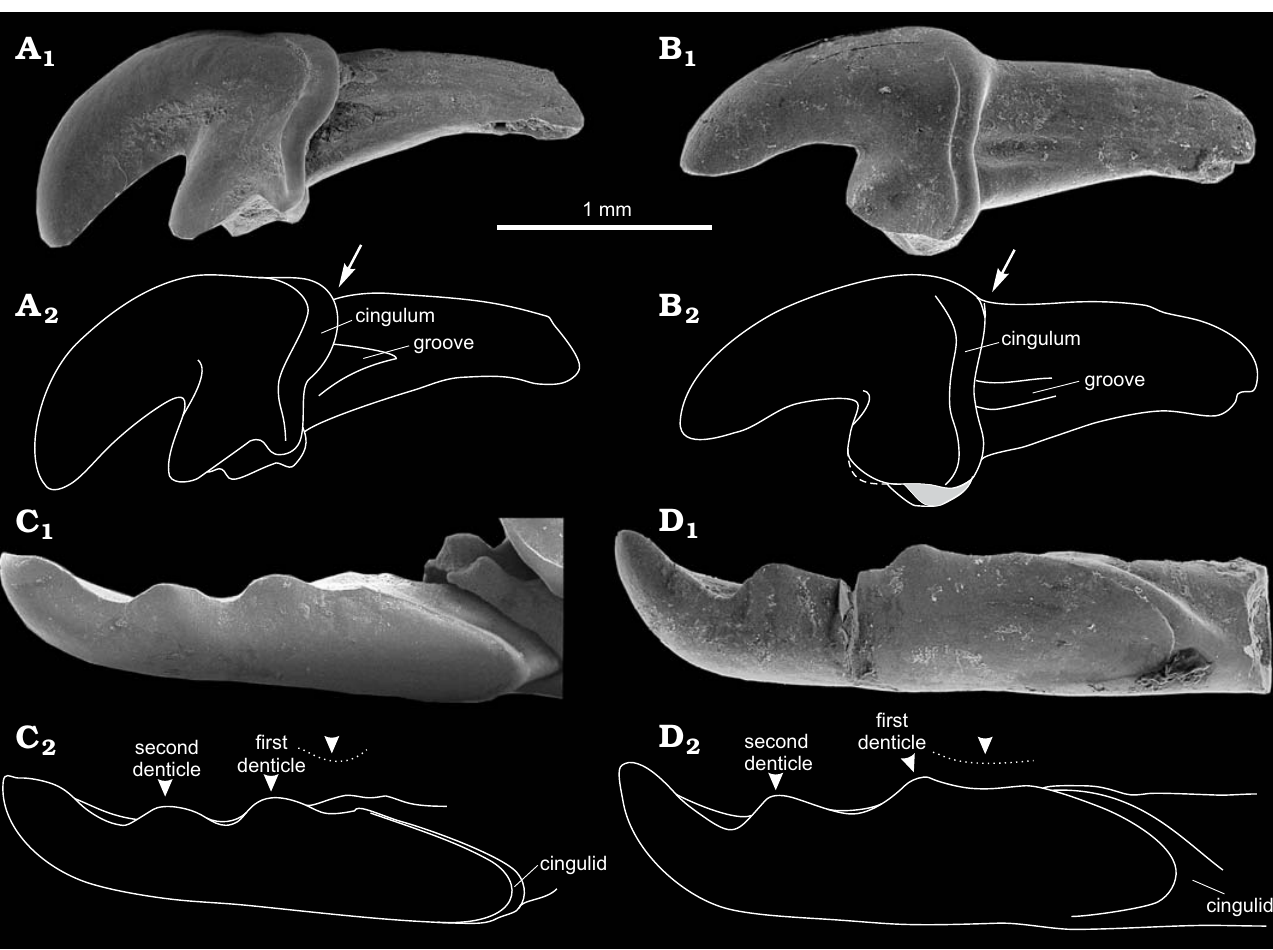
Fig. 2. Crocidosoricine shrews Shargainosorex angustirostris gen. et sp. nov. from middle Miocene Sharga 2 locality, Mongolia (A, C), and Miosorex grivensis (Deperet, 1892) from middle Miocene of La Grive St. Alban, France (B, D). A . ZISP 104324/1068 (paratype), right I1 (mirrored) in buccal view. B . ZISP 103200/6, left I1 in buccal view; dashed line and grey area on B 2 indicate damaged tip and base of talon. Arrows indicate crown-root junction, stepped (A 2 ), or smooth (B 2 ). C . ZISP 104323 (holotype), fragment of left i1 in buccal view. D . ZISP 103200/7, left i1 in buccal view. Arrowheads indicate first and second denticles of i1; dotted line indicates notch until first denticle. Photographs (A 1 –D 1 ), explanatory drawings (A 2 –D 2